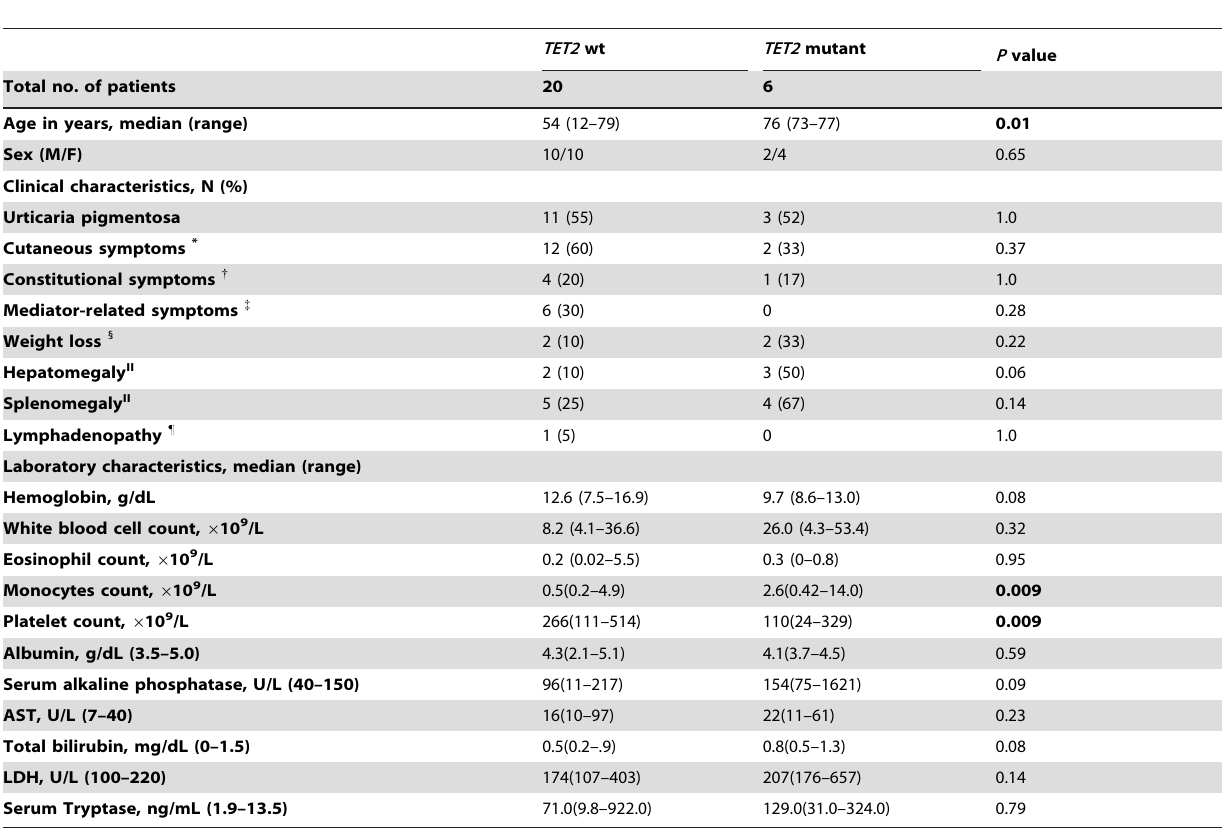
Table 4. Clinical and laboratory features of mastocytosis patients stratified according to TET2 mutations.